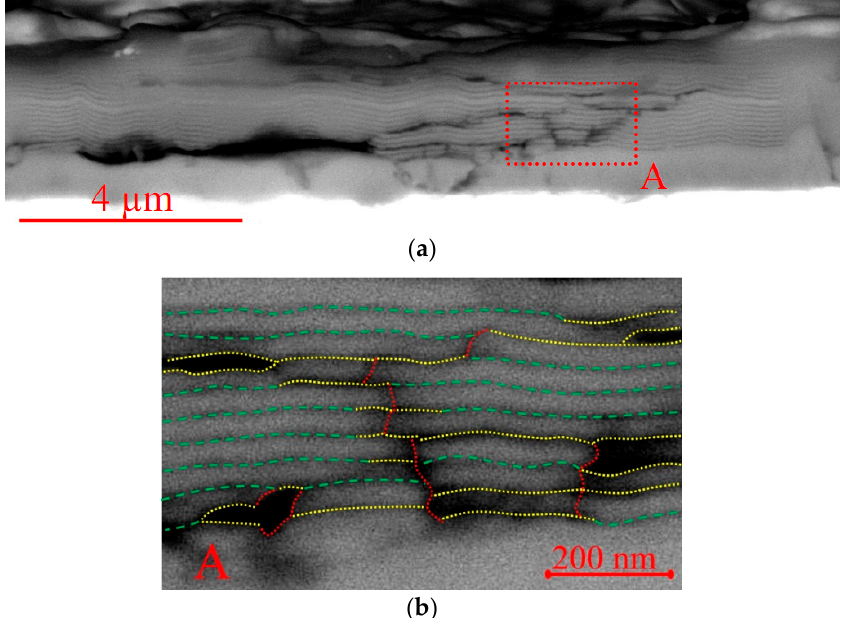
Figure 18. Mechanism of wear and failure for the cutting tool with coating S2. Area adjacent to wear